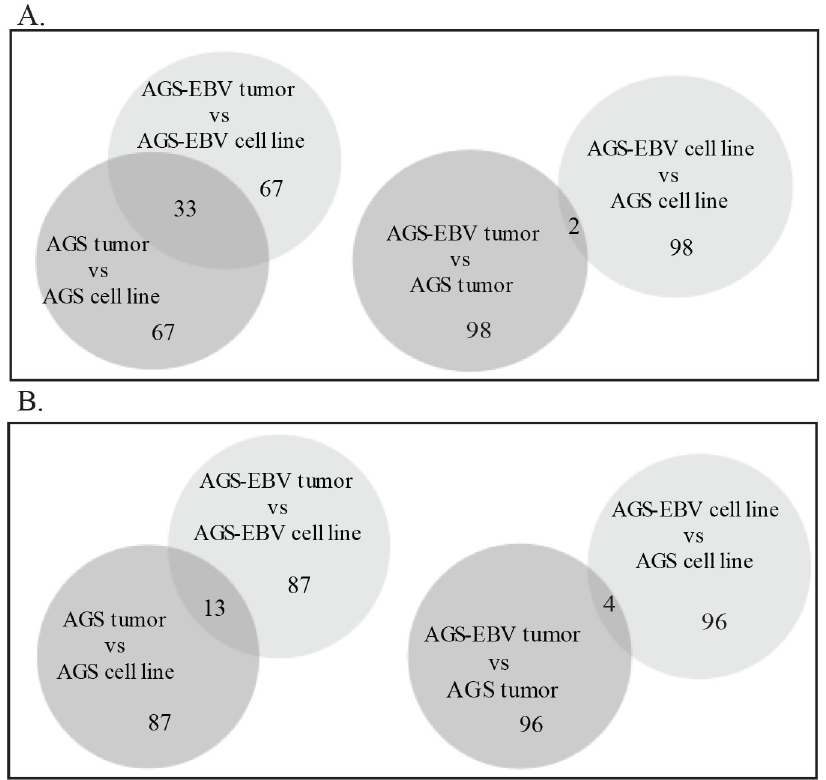
Fig 6. Comparison of the top 100 down regulated and upregulated genes in the data sets. A. Venn diagrams showing comparisons of the top 100 down regulated genes in each data set presented in S4 Table. B. Venn diagrams showing the comparison of the top 100 up regulated genes in each data set presented in S4